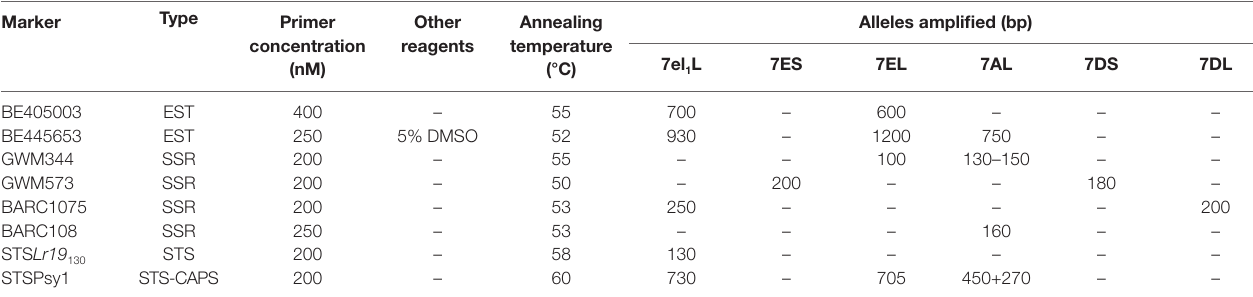
TABLE 1 | Group 7 molecular markers used to identify wheat— Thinopyrum spp. genotypes in the course of the work.